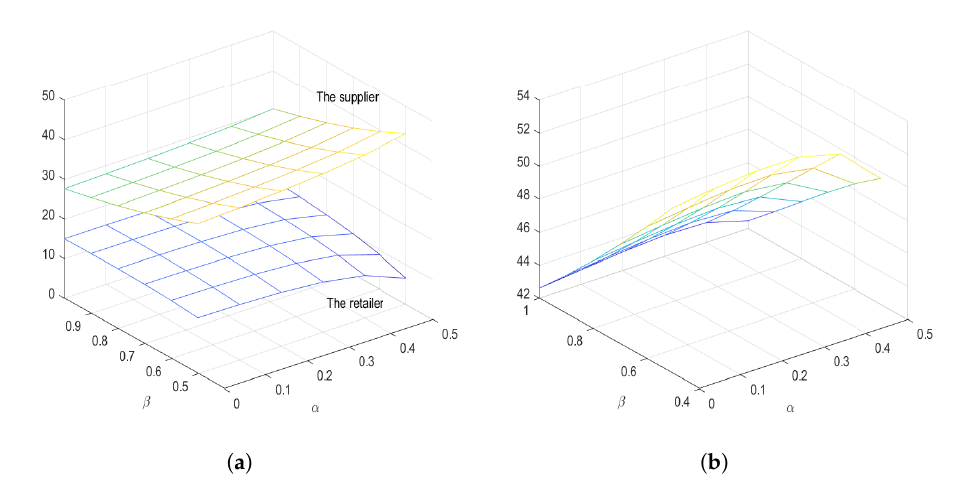
Figure 7. Impacts of the revenue-sharing ratio α and the cost-sharing ratio β on the equilibrium profits. ( a ) Equilibrium profits of the supplier and retailer; ( b ) equilibrium profit of the whole supply